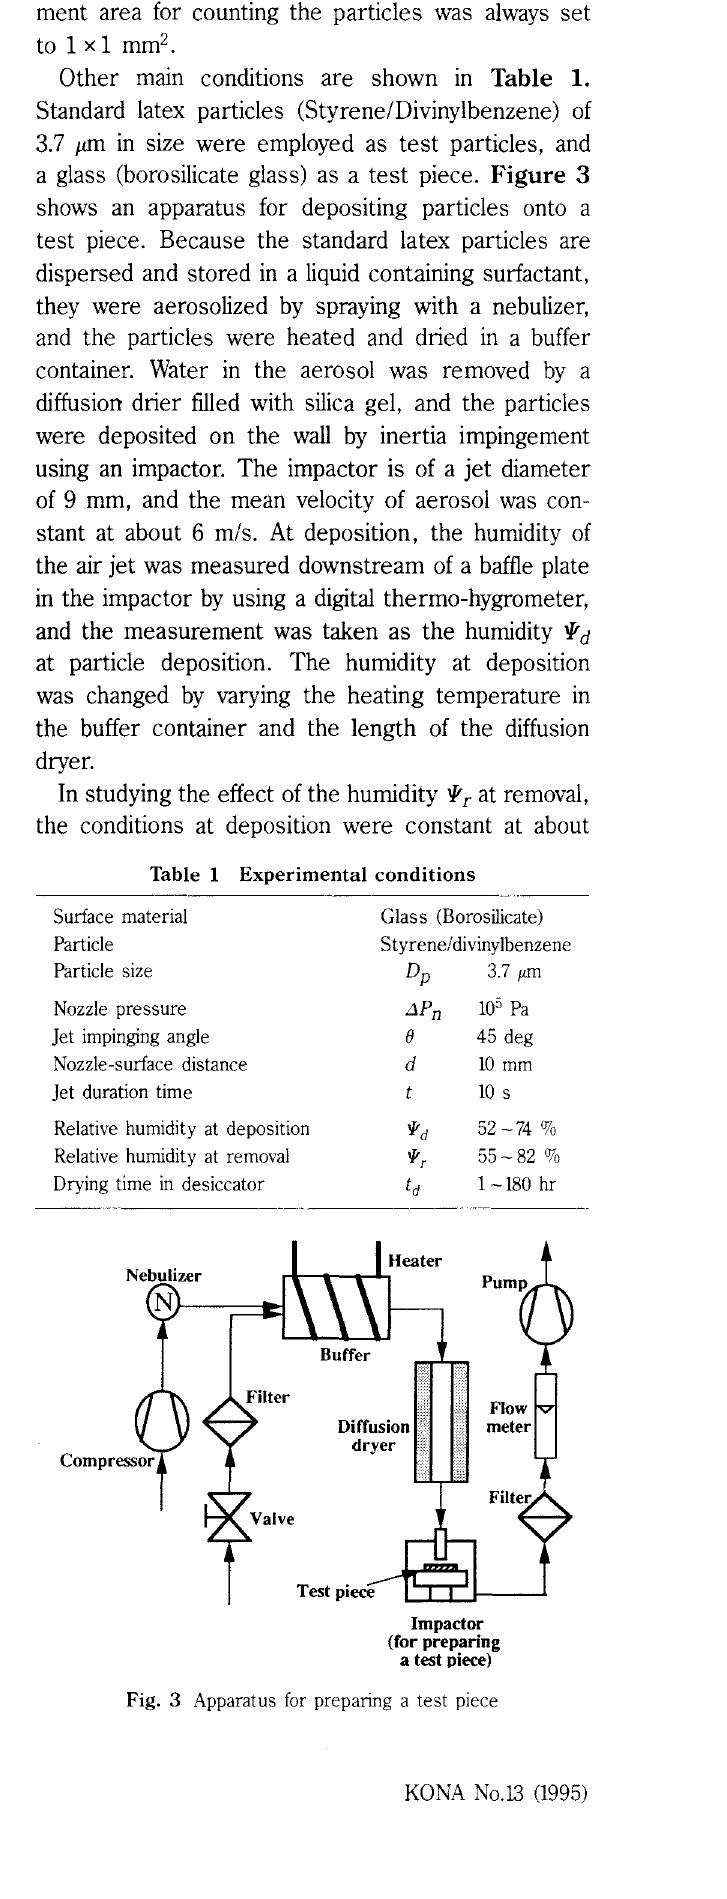
Fig. 3 Apparatus for preparing a test